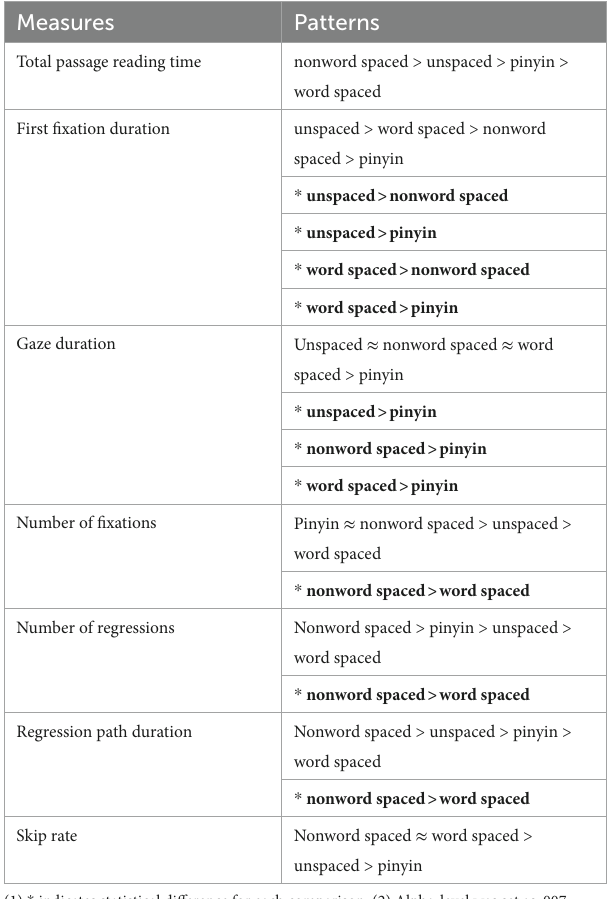
TABLE 5 Processing patterns for L2 learners.